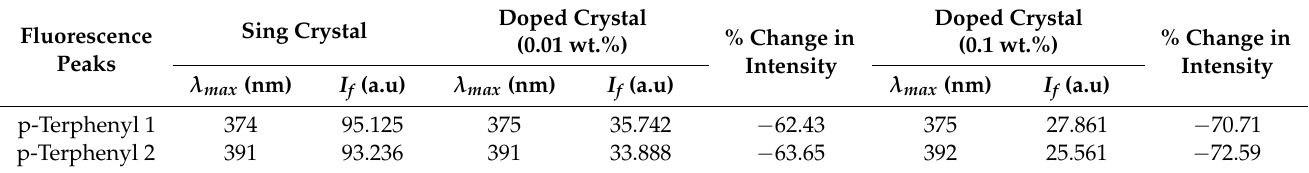
Table 3. Fluorescence characteristic peaks representing p-terphenyl in pure and pentacene-doped p-terphenyl